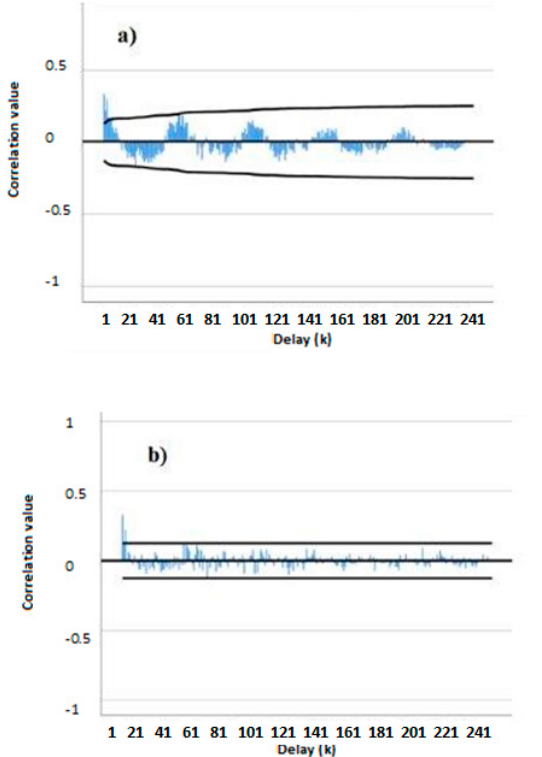
Figure 5. ( a ) Total autocorrelation and ( b ) partial autocorrelation of weekly beta activity concentra- tions over the period 2014–2018 in Bilbao. The correlation lines are represented in black and the correlation values for the delays are in blue.